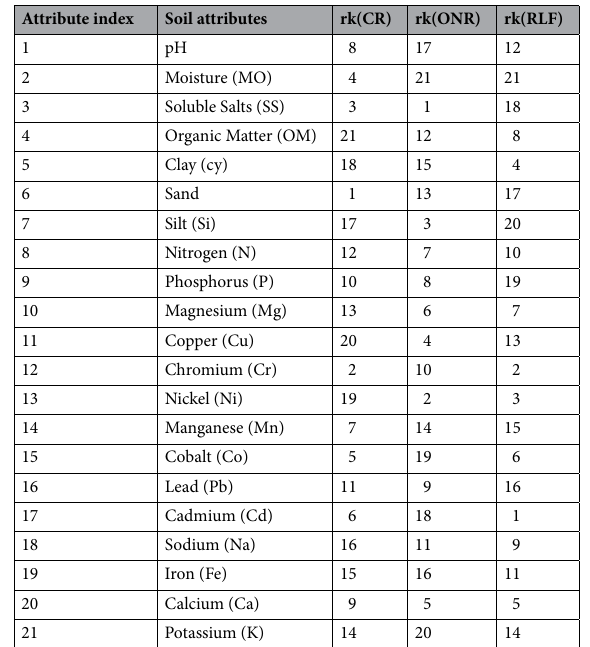
Table 3. Attribute-ranking for C. burnetii soil attribute dataset by different Feature-ranking